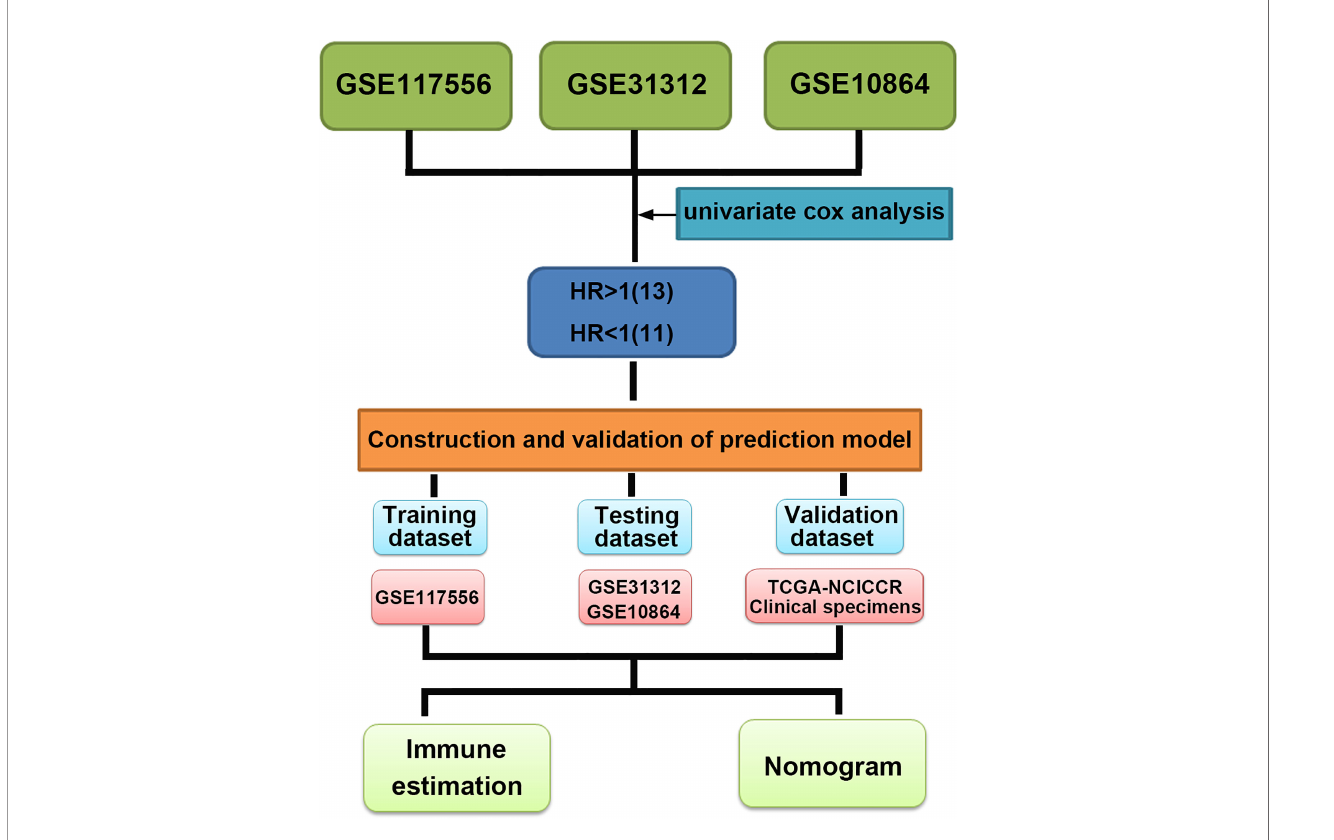
FIGURE 1 | Multistep analysis of the